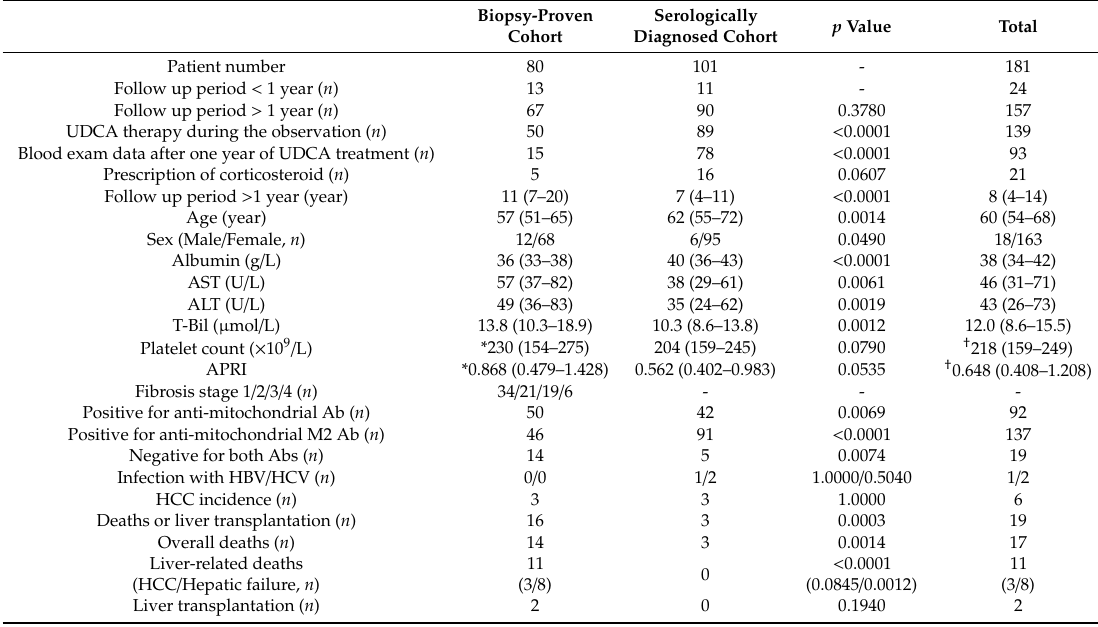
Table 1. Patient baseline